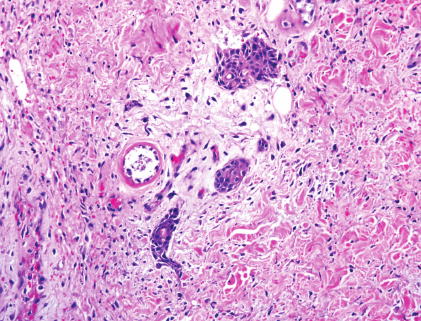
Figure 9: Eccrine squamous syringometaplasia: bland appearing squamous islands in the dermis centered around eccrine lumina. Scattered lymphocytes are present in the surrounding dermis. (H&E, ×